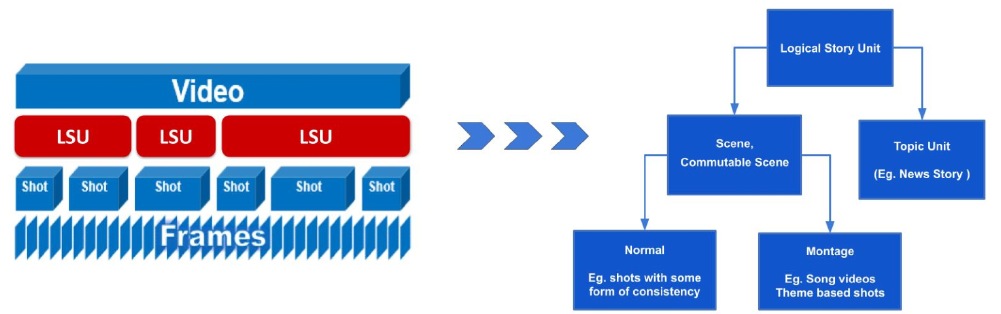
Figure 1. Pictorial representation of the structure of video, detailing the position and definition of a logical story unit (LSU). As shown in the flow diagram, an LSU can either be a scene or a topic unit. This paper predominately focuses on normal scene- and topic-unit-type